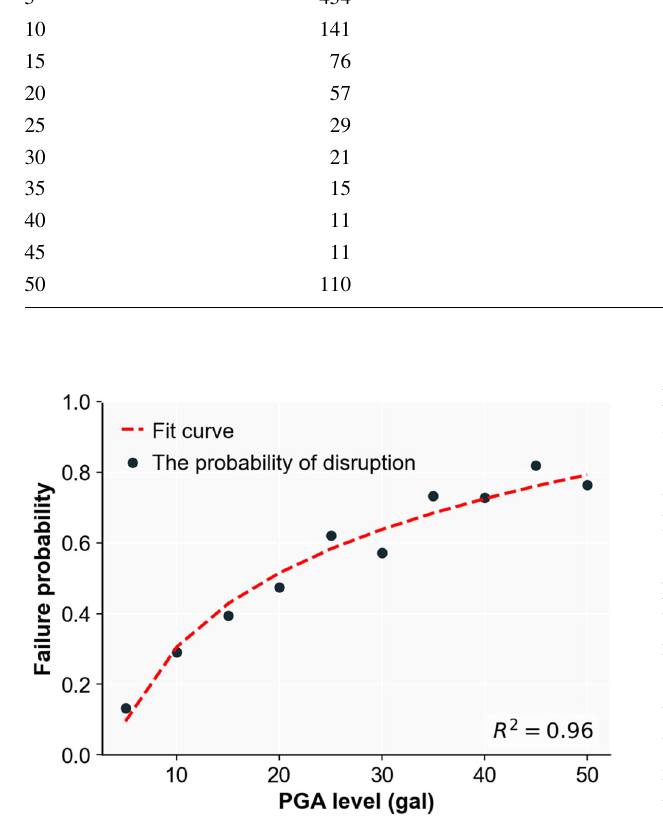
Fig. 5 The generated failure fragility curve of train services.